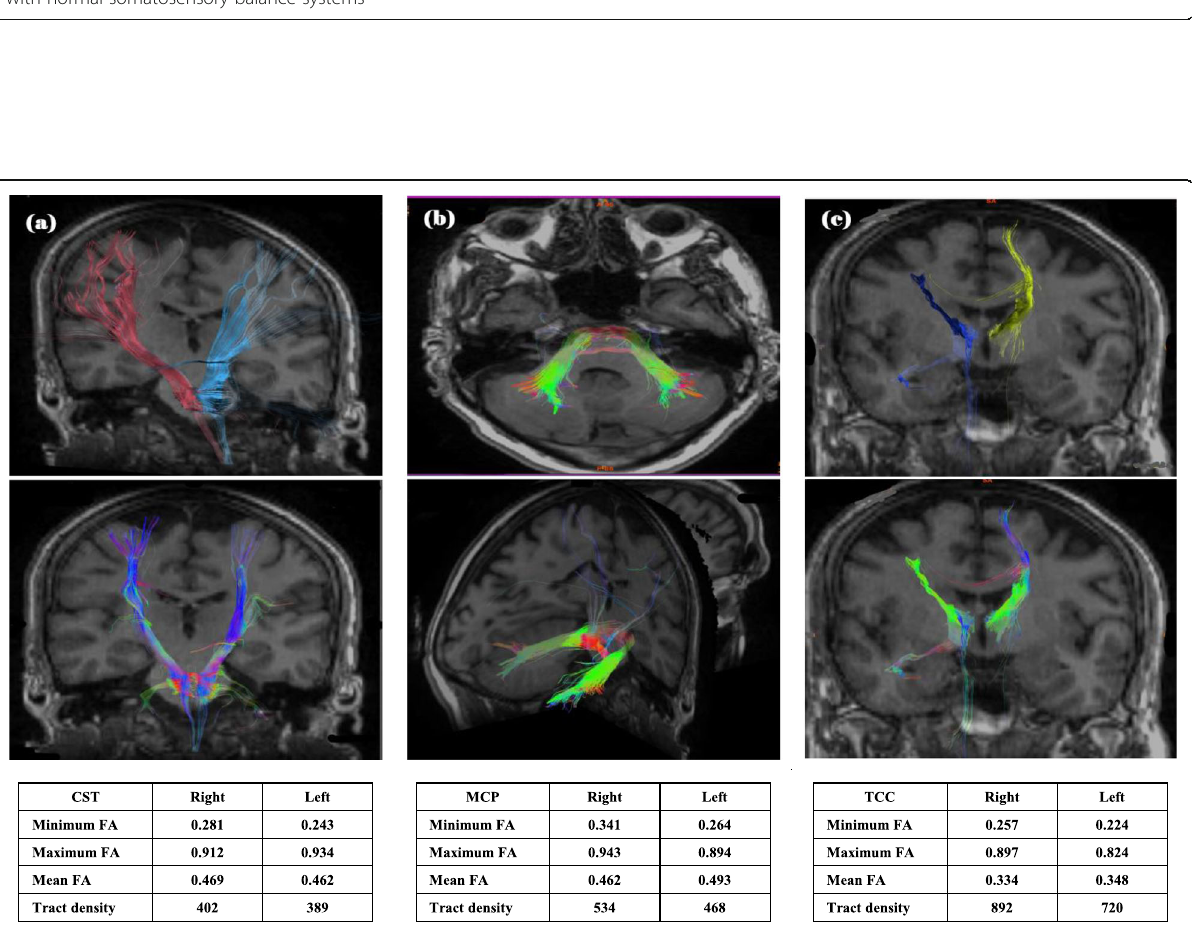
Fig. 2 Diffusion tensor tractography of an included essential tremor patient a corticospinal, b middle cerebellar peduncle, and c thalamo-cortical tractography. FA: fractional